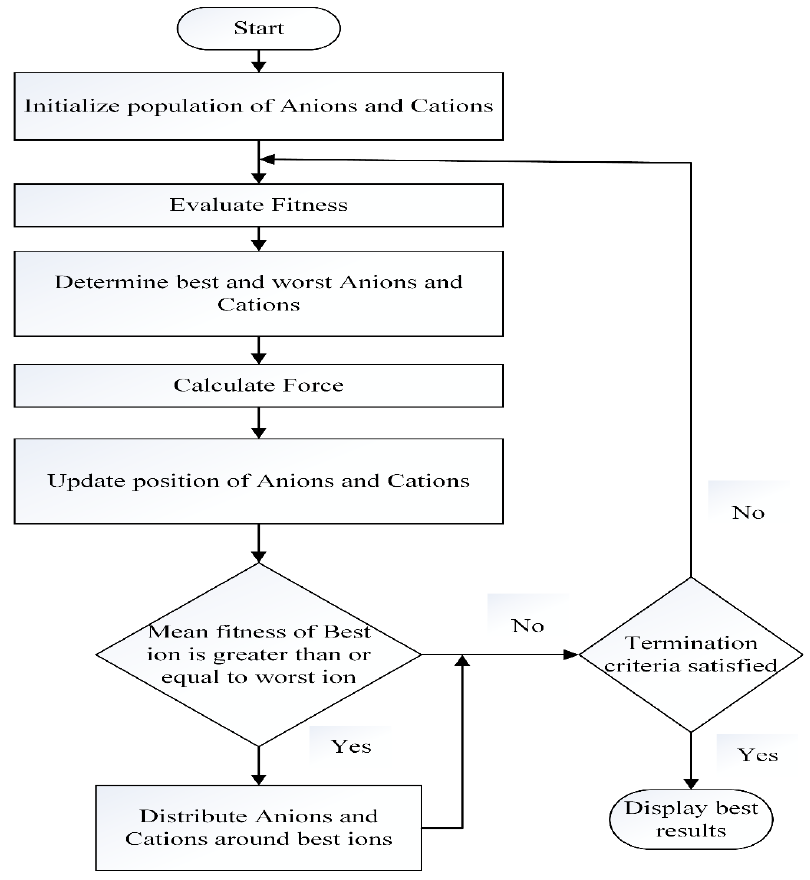
Fig. 3. The standard procedure of the IMO